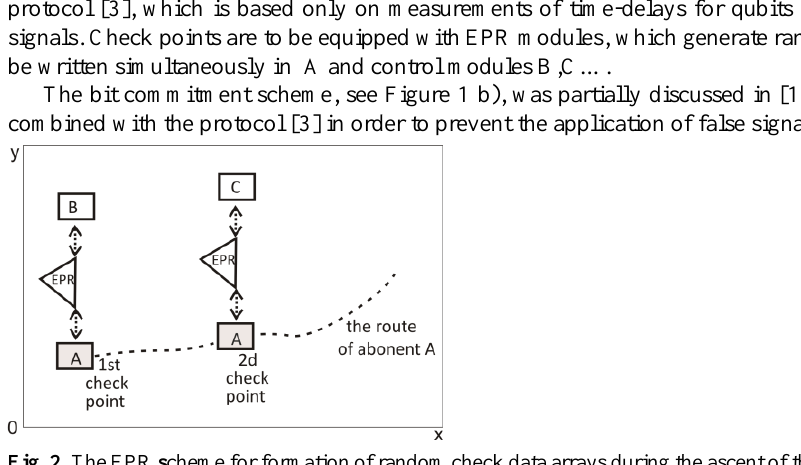
Fig. 2. The EPR s cheme for formation of random check data arrays during the ascent of the route, when mobile abonent A visits check points ( B , C,